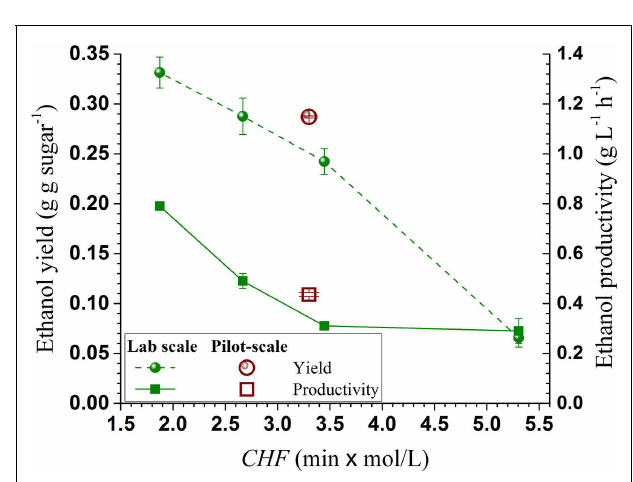
FIGURE 5 | Comparisons of ethanol productivity and yield from the present pilot-scale study (40kg) with those from a lab-bench scale study (150g) plotted against pretreatment severity CHF